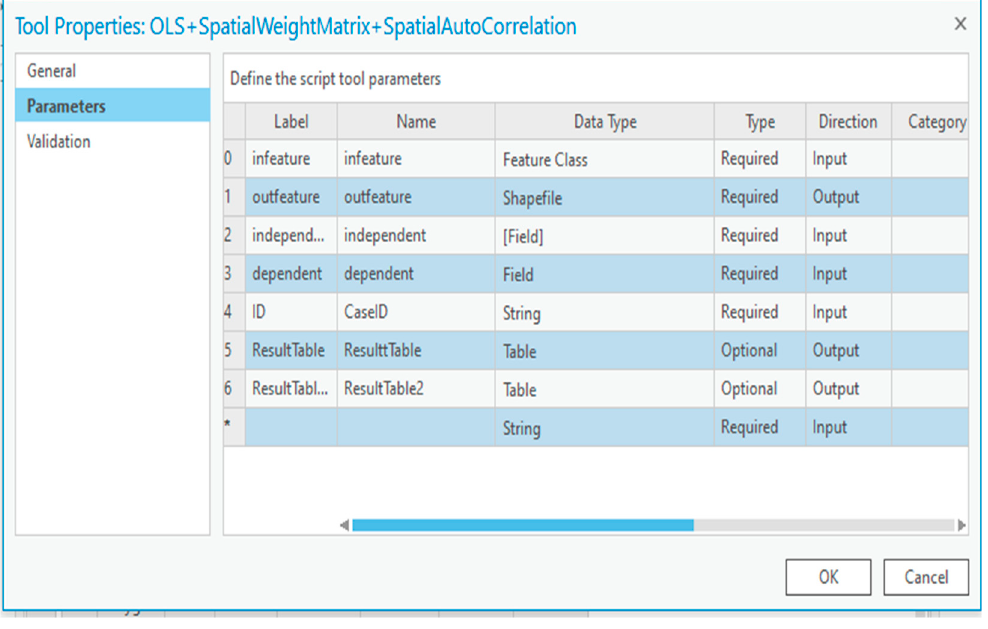
Figure 4. Set up parameters of the OLS tool.